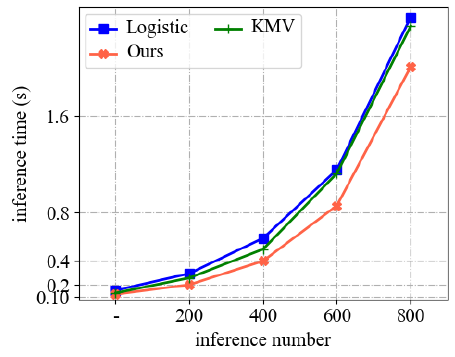
Figure 5. The three models in the case of different reasoning quantities.